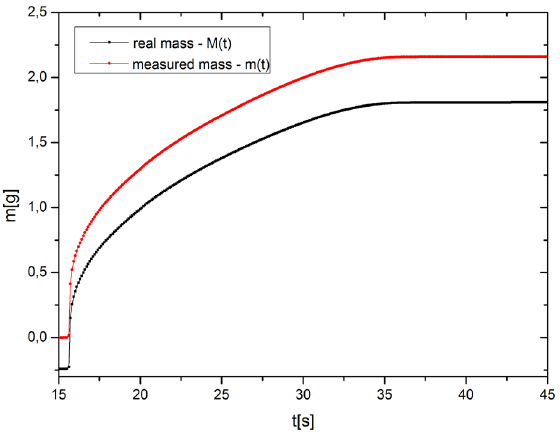
Figure 6: The influence of meniscus related parasitic effects on the measured